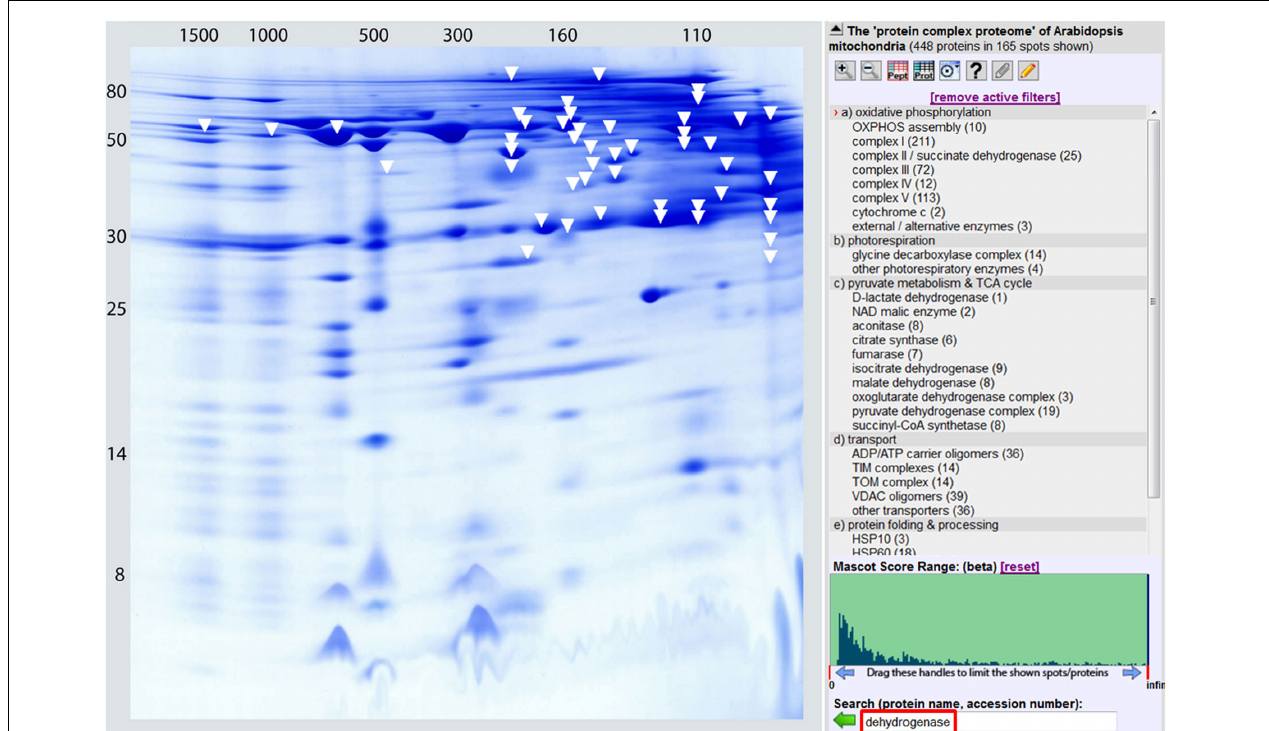
FIGURE 3 | The dehydrogenase subproteome of plant mitochondria. Mitochondrial proteins from Arabidopsis thaliana were separated by 2D Blue native/SDS PAGE and displayed via GelMap (https://gelmap.de/231#). Protein separation under native condition was from left to right, protein separation in the presence of SDS from top